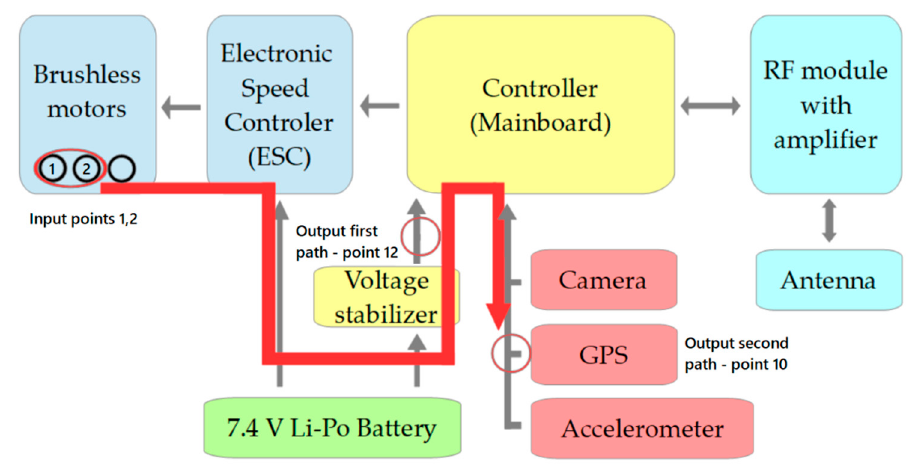
Figure 11. Scheme of measurement for described results.